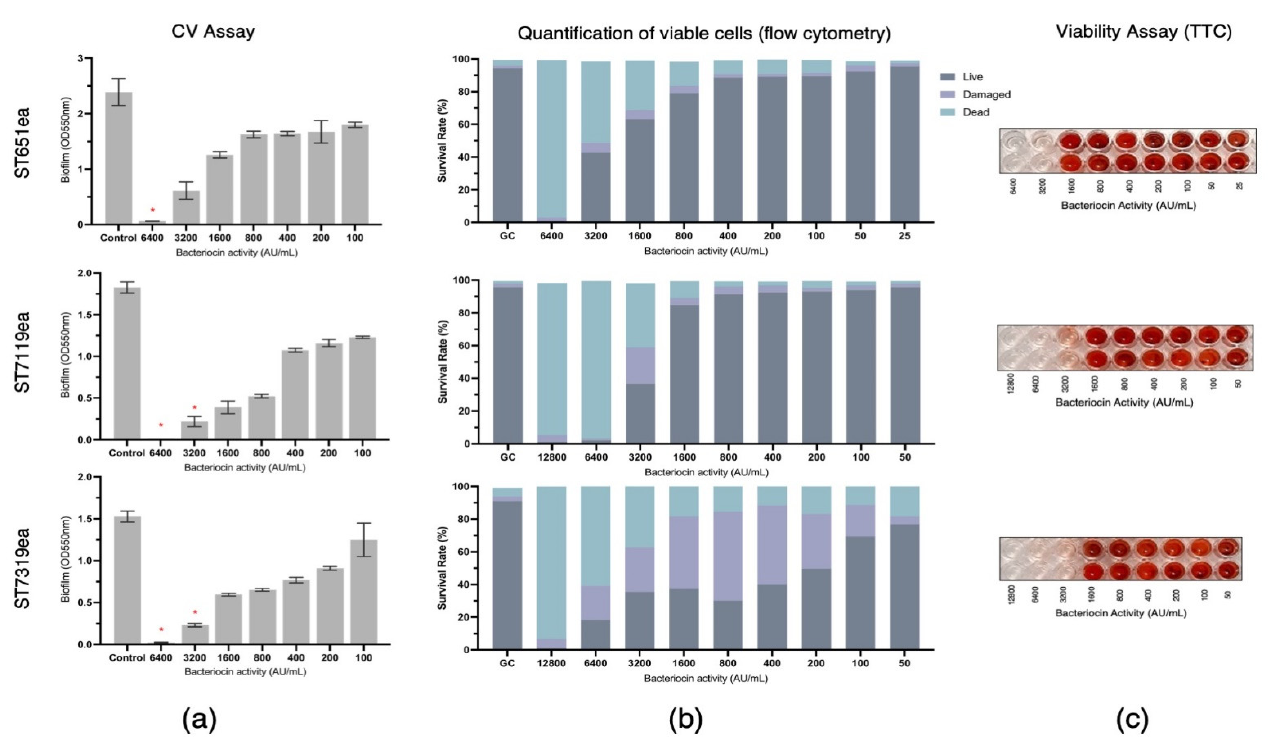
Figure 2. Eradication of Enterococcus faecium VRE19 biofilm by semi-purified bacteriocins ST651ea, ST7119ea, and ST7319ea after 1 h challenge. Biofilms were quantified by ( a ) crystal violet assay (significant changes in biofilms after challenge were indicated by * at p ≤ 0.05 ); ( b ) quantification of live, dead, and damaged cells through flow cytometry; and confirmation of ( c ) cell viability using TTC.